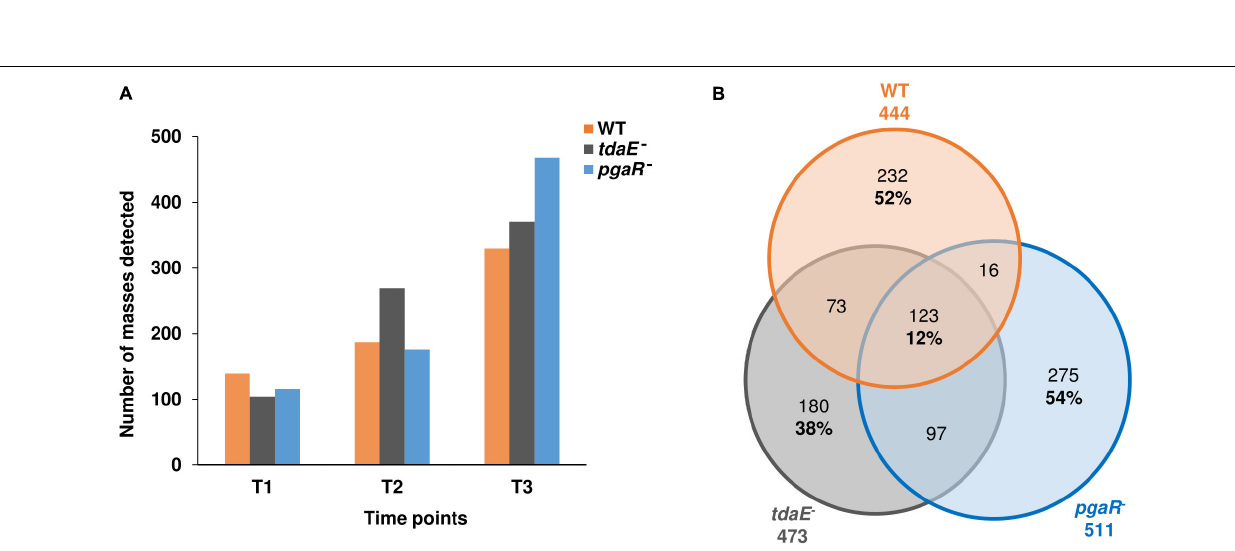
Frontiers in Microbiology |